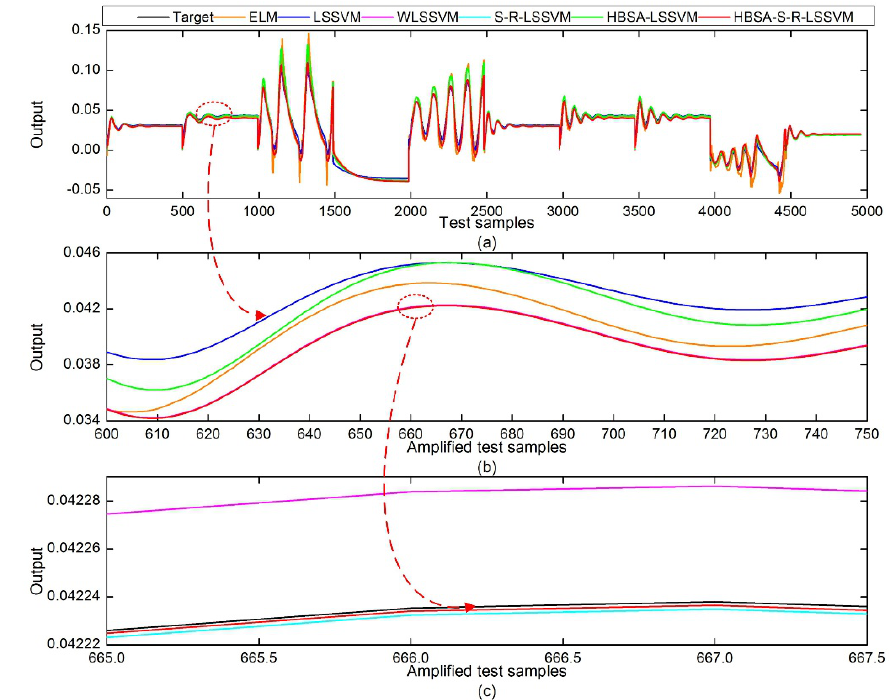
Figure 9. Comparison of the predicted output of each identification model and the targeted output under Scheme A.